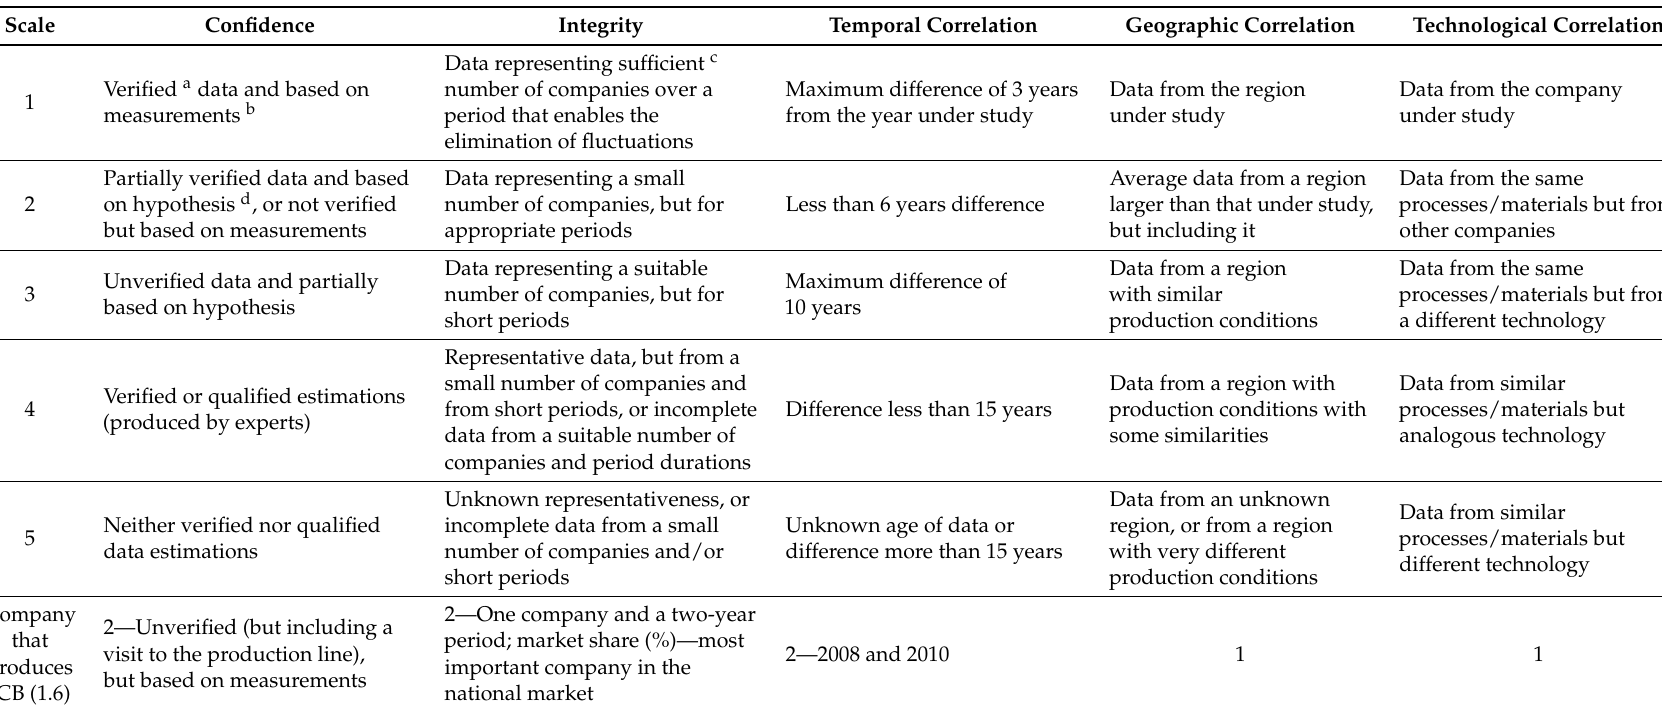
Table 3. Quality of the information used in an LCA study (adapted from [18]) and in the Life Cycle Inventory (LCI) of the ICB studied in this paper (adapted from [5]).